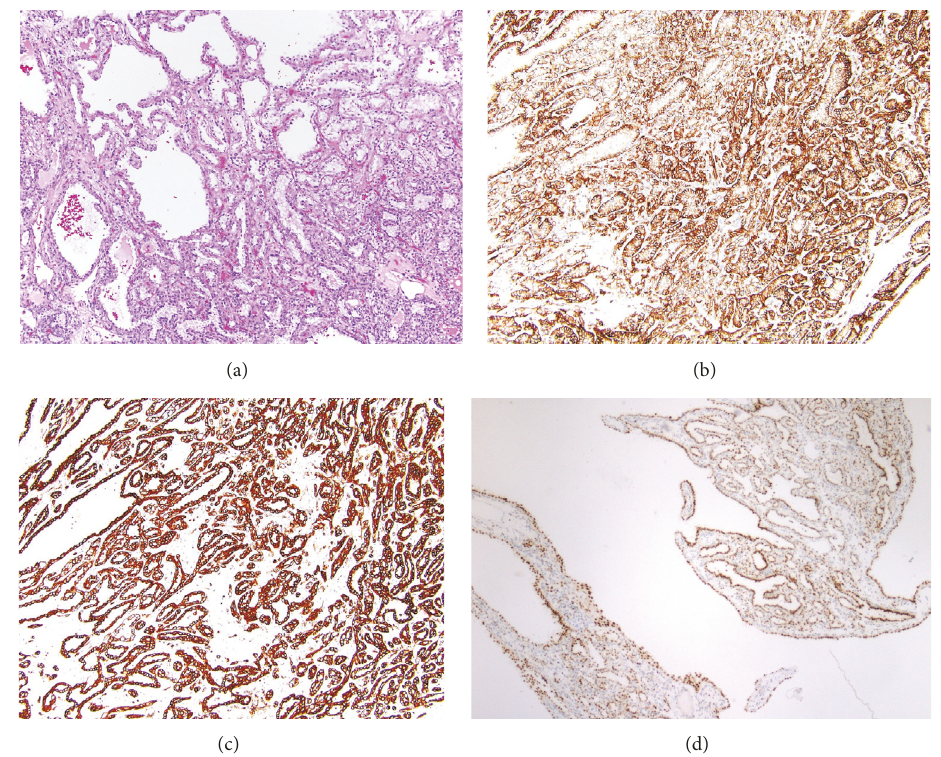
Figure 2: Representative photomicrographs of the CCPRCC component. (a) H&E section shows tubular, papillary, and cystic components of classic CCPRCC with low-grade clear cells in linear alignment ( × 20) with (b) CAIX showing positivity in a “cup-like” pattern ( × 20), (c) diffuse positivity for CK7 ( × 10), and (d) GATA3 showing diffuse staining ( × 10).